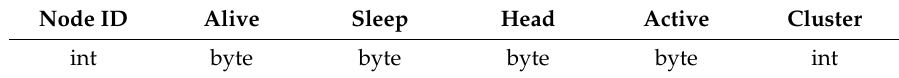
Table 1. Contents of each